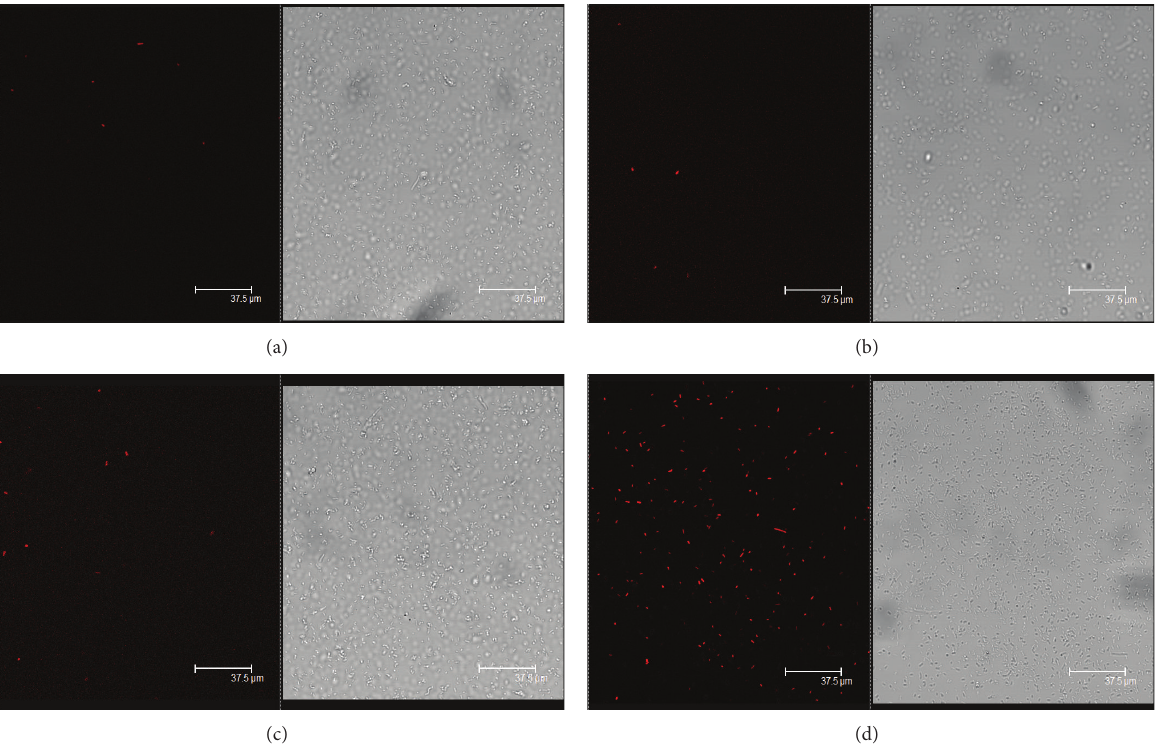
Figure 3: Membrane permeability of E. coli cells was measured using confocal laser scanning microscopy with PI staining after photodynamic treatment of hypocrellin B (25 𝜇 M), in which the energy density of blue light was 12J/cm 2 . (a) Sham control; (b) hypocrellin B treatment alone; (c) blue light irradiation alone; and (d) photodynamic treatment of hypocrellin